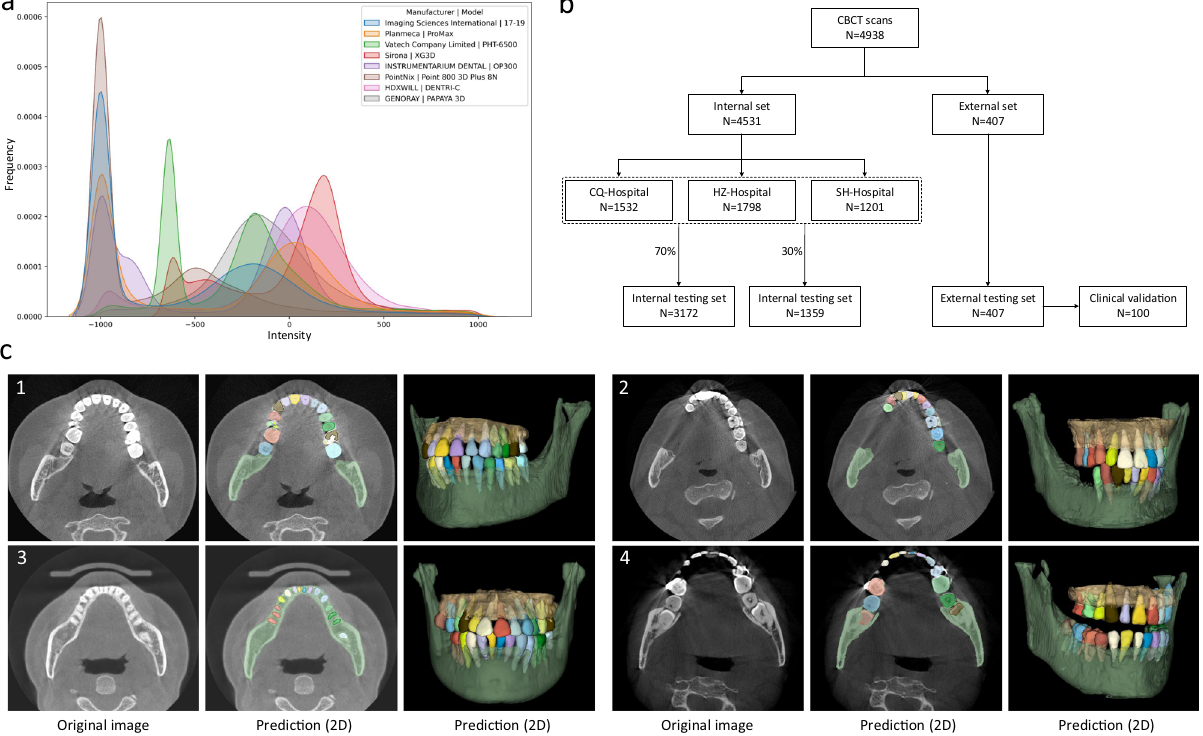
Fig. 1 Data information and segmentation results in the multi-center CBCT dataset. a The overall intensity histogram distributions of the CBCT data collected from different manufacturers. b The CBCT dataset consists of internal set and external set. The internal set collected from three hospitals is randomly divided into the training dataset and internal testing dataset. All 407 external CBCT scans, collected from 12 dental clinics, are used as external testing dataset, among which 100 CBCT scans are randomly selected for clinical validation by comparing the performance with expert radiologists. c Qualitative comparison of tooth and bone segmentation on the four center sets. The original CBCT images are shown in the 1st column, and the segmentation results in 2D and 3D views are shown in the 2nd and 3rd columns,